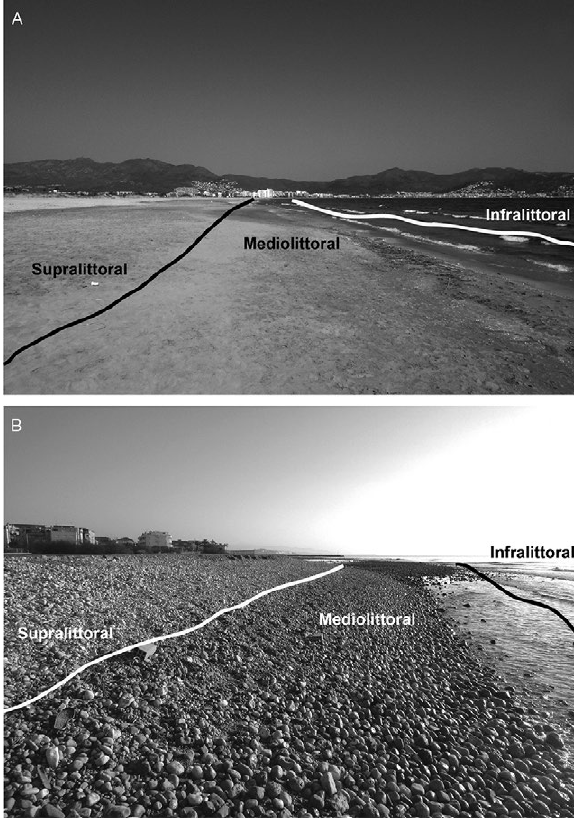
Fig. 2. – The three littoral levels on a sand-dominated (A) and a cobble-dominated (B)